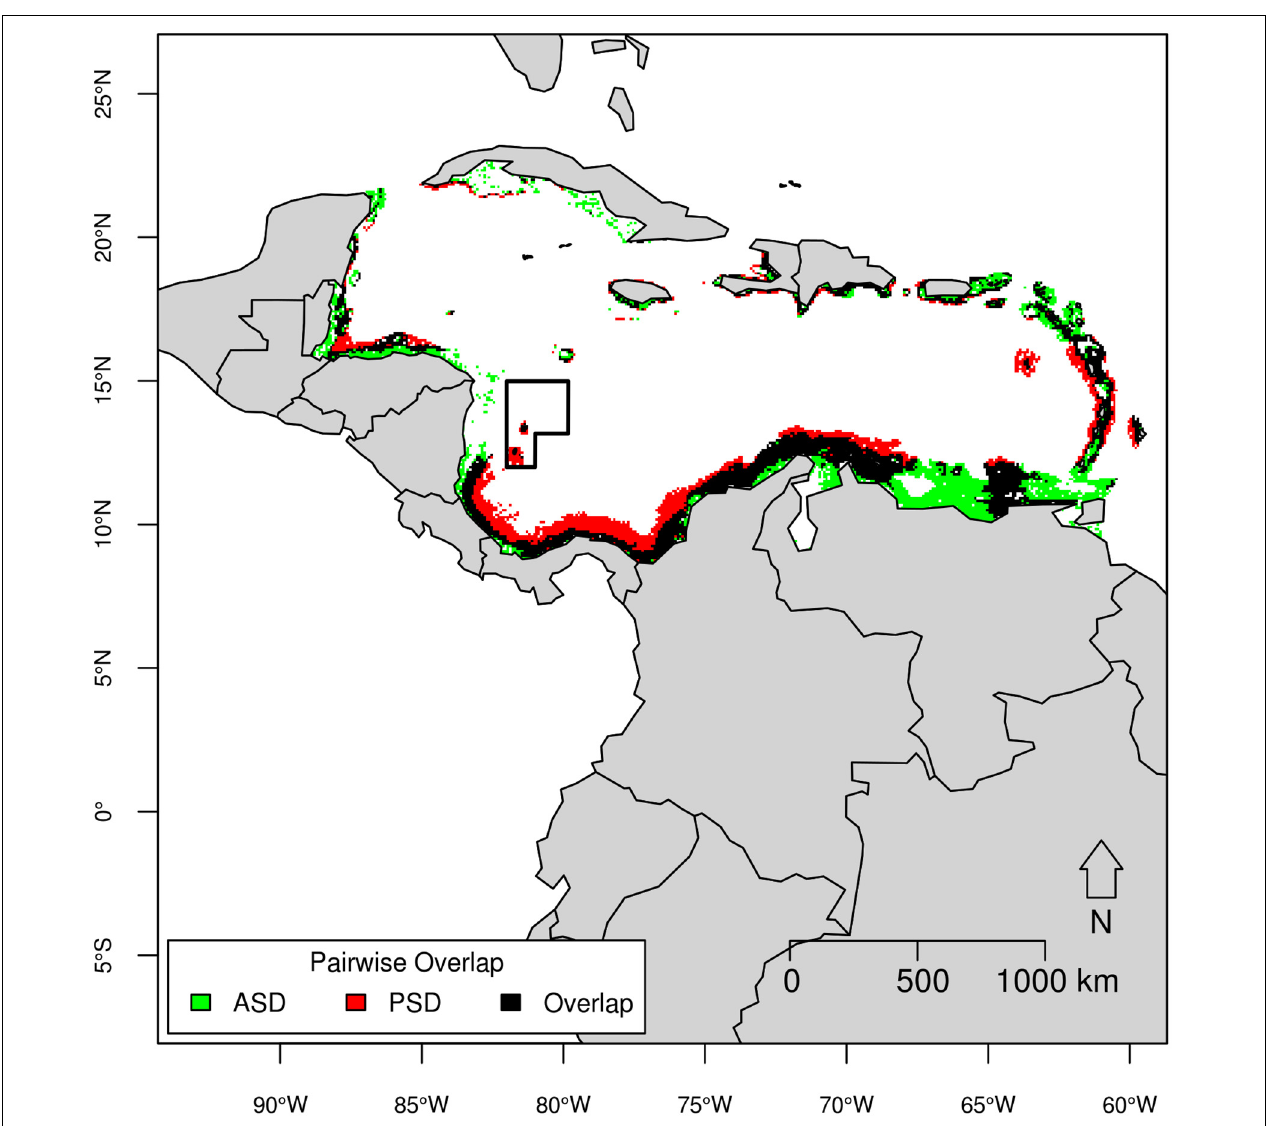
FIGURE 6 | Pairwise overlap map of Atlantic spotted dolphin (ASD) and pantropical spotted dolphin (PSD) based on the threshold of equal test sensitivity and specificity.